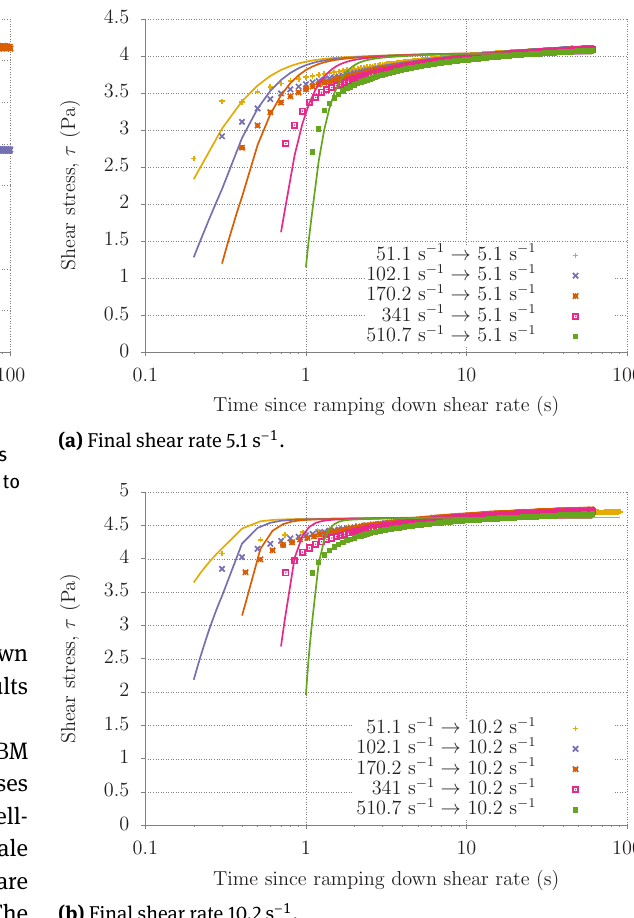
Figure 9: Measurements and model predictions for shear stresses in the WBM following shear rate steps down to shear rates of 5.1 s −1 and 10.2 s −1